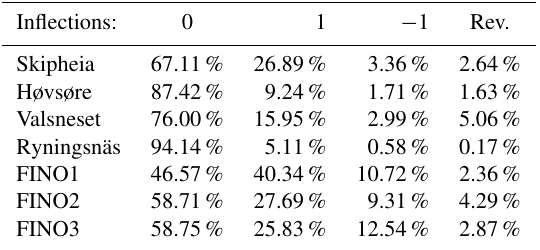
Table 4. Local maxima result if all sites are restricted to only four measurement heights. At all sites except Skipheia, the common heights z = (40, 60, 80, 100m) were used; at Skipheia, z = (25, 40, 70, 100m) were